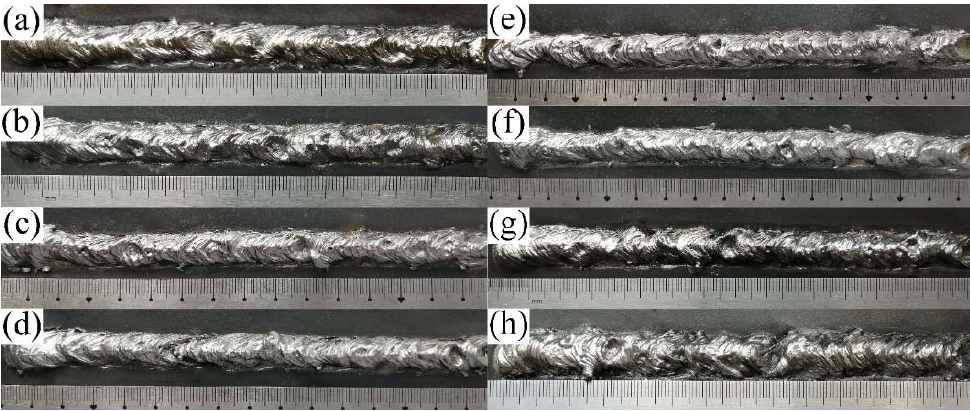
Figure 9. Weld appearances at different excitation voltages and frequencies: ( a ) conventional UWW; ( b ) 20 V–30 kHz; ( c ) 40 V–30 kHz; ( d ) 60 V–30 kHz; ( e ) 40 V–20 kHz; ( f ) 40 V–40 kHz; ( g ) 40 V–50 kHz; ( h ) 40 V–60 kHz (scale 1 mm).